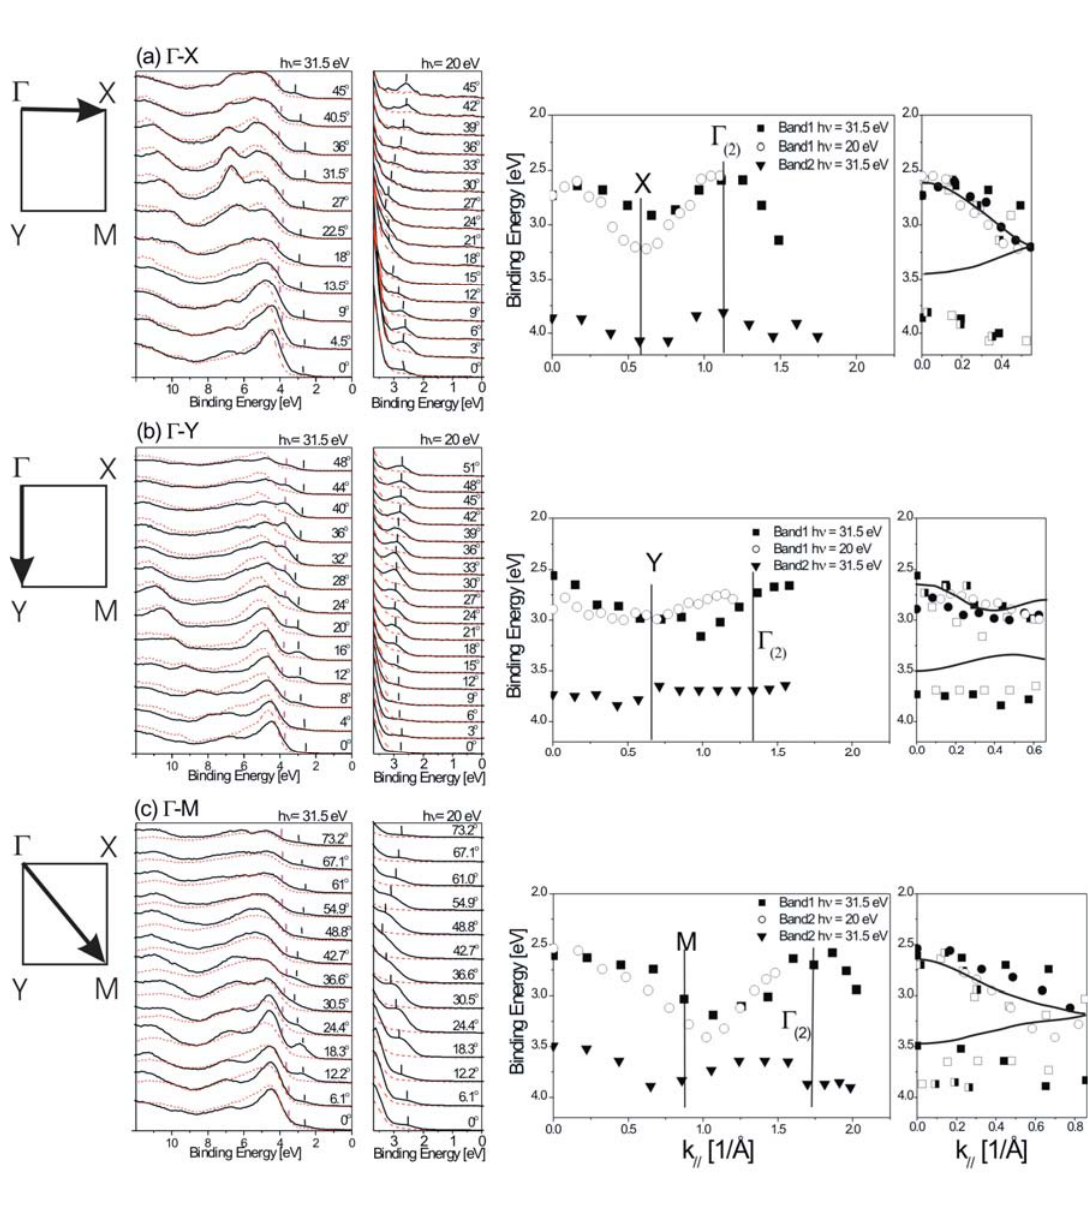
Figure 10 . Angle-resolved photoemission measurements for the reduced (solid black lines) and stoichiometric (dashed red lines) SnO (101) surfaces along low symmetry directions of the surface 2 Brillouin zone. On the right the dispersion of surface states for the reduced (101) surface are plotted. An effective electron mass of 0.7 times the free electron mass has been assumed to fit the symmetry of the surface Brillouin zone. A reduced zone-scheme is shown on the plots on the far right. The solid lines represent DFT-calculated surface states. (reproduced with permission from ref.